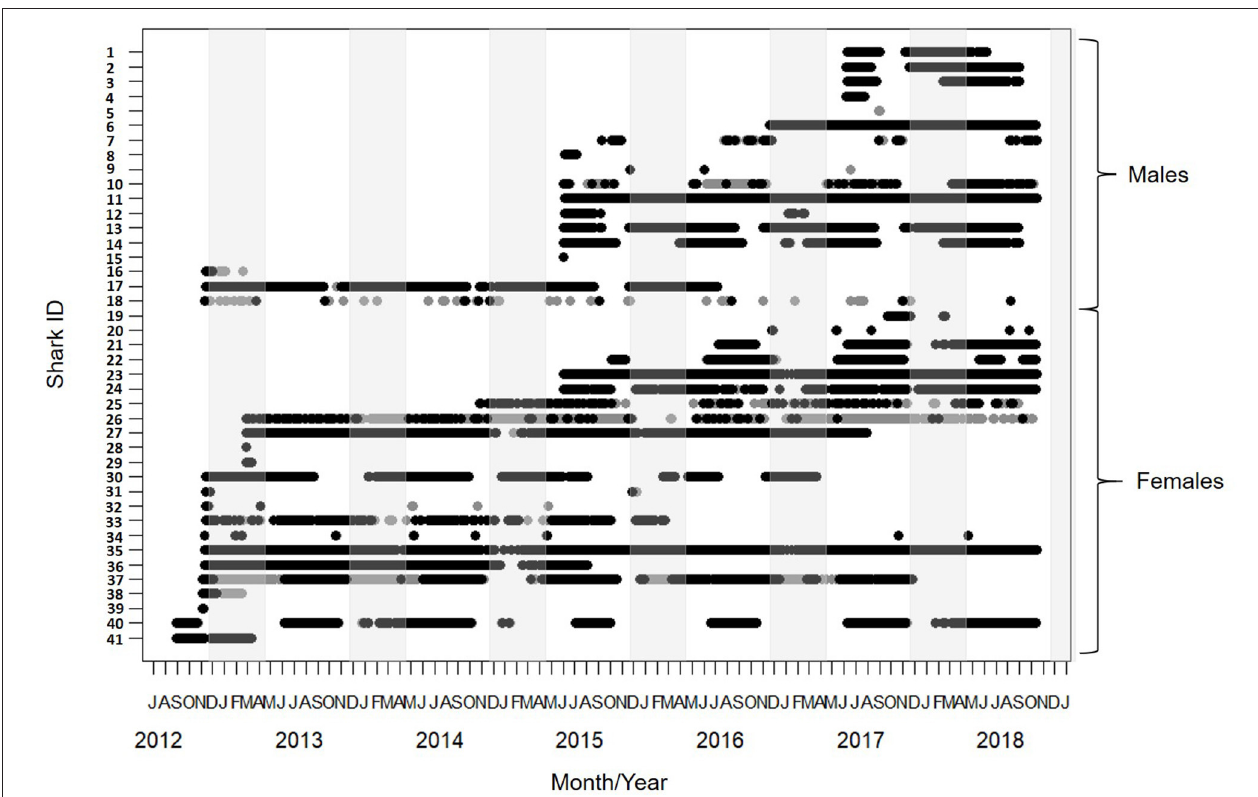
FIGURE 2 | Detection span of 41 lemon sharks tagged between August 2012 and October 2018. Black circles show detections on receivers only within the Mangrove Bay array. Gray circles show detections on receivers outside the Mangrove Bay array. Males (Tag ID 1 - 18) and females (Tag ID 19 - 41) plotted separately. Light gray shading covers the period between November and April when parturition is thought to occur. Fresh mating scars were observed in